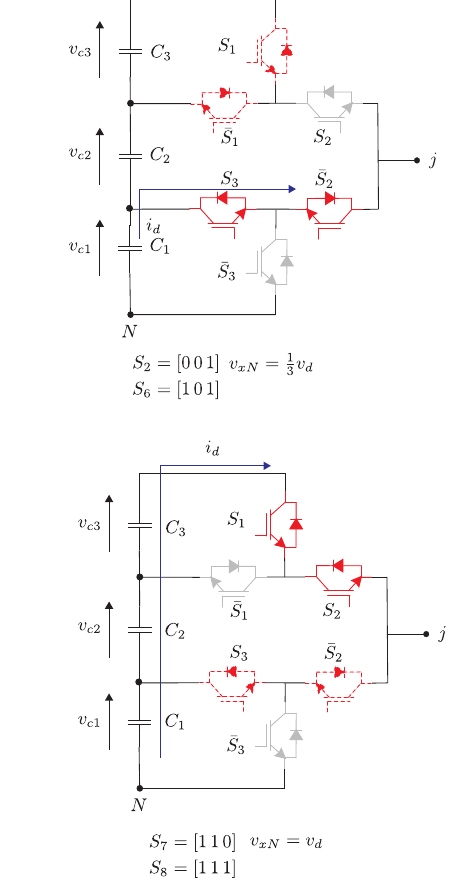
Figure 4. Current paths for each switching